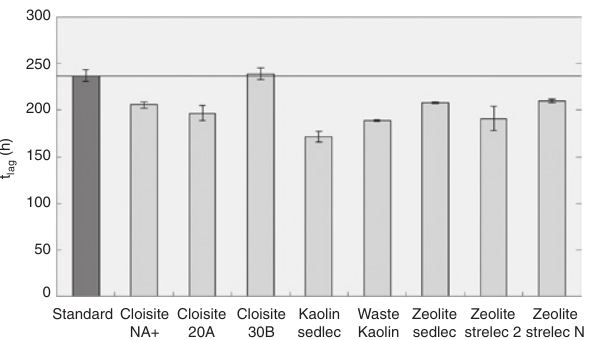
Figure 9: The lag phase during the PVA 72-10 biodegradation with laboratory-adapted inoculum in the presence of the selected group of clay minerals ( ± standard